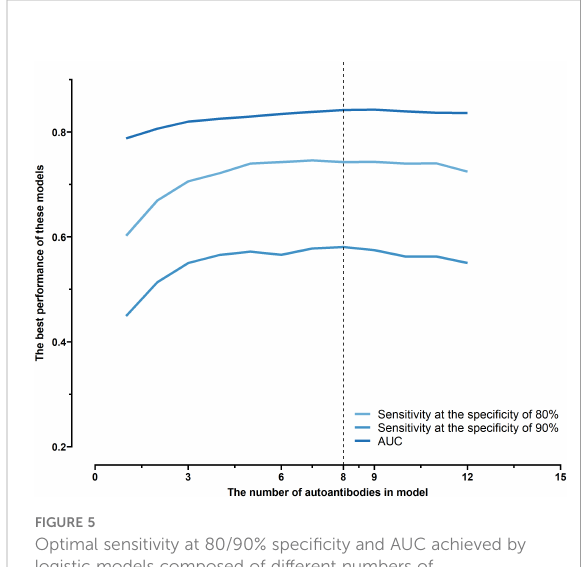
FIGURE 5 Optimal sensitivity at 80/90% speci fi city and AUC achieved by logistic models composed of different numbers of autoantibodies under 5-fold